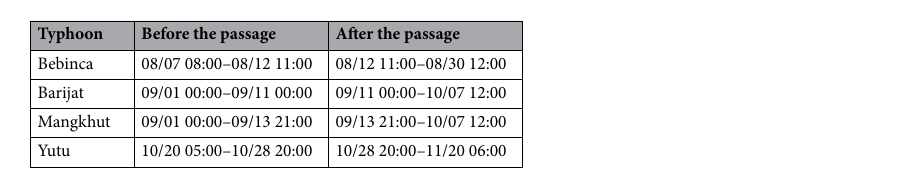
Table 1. Typhoon information affecting mooring during observation